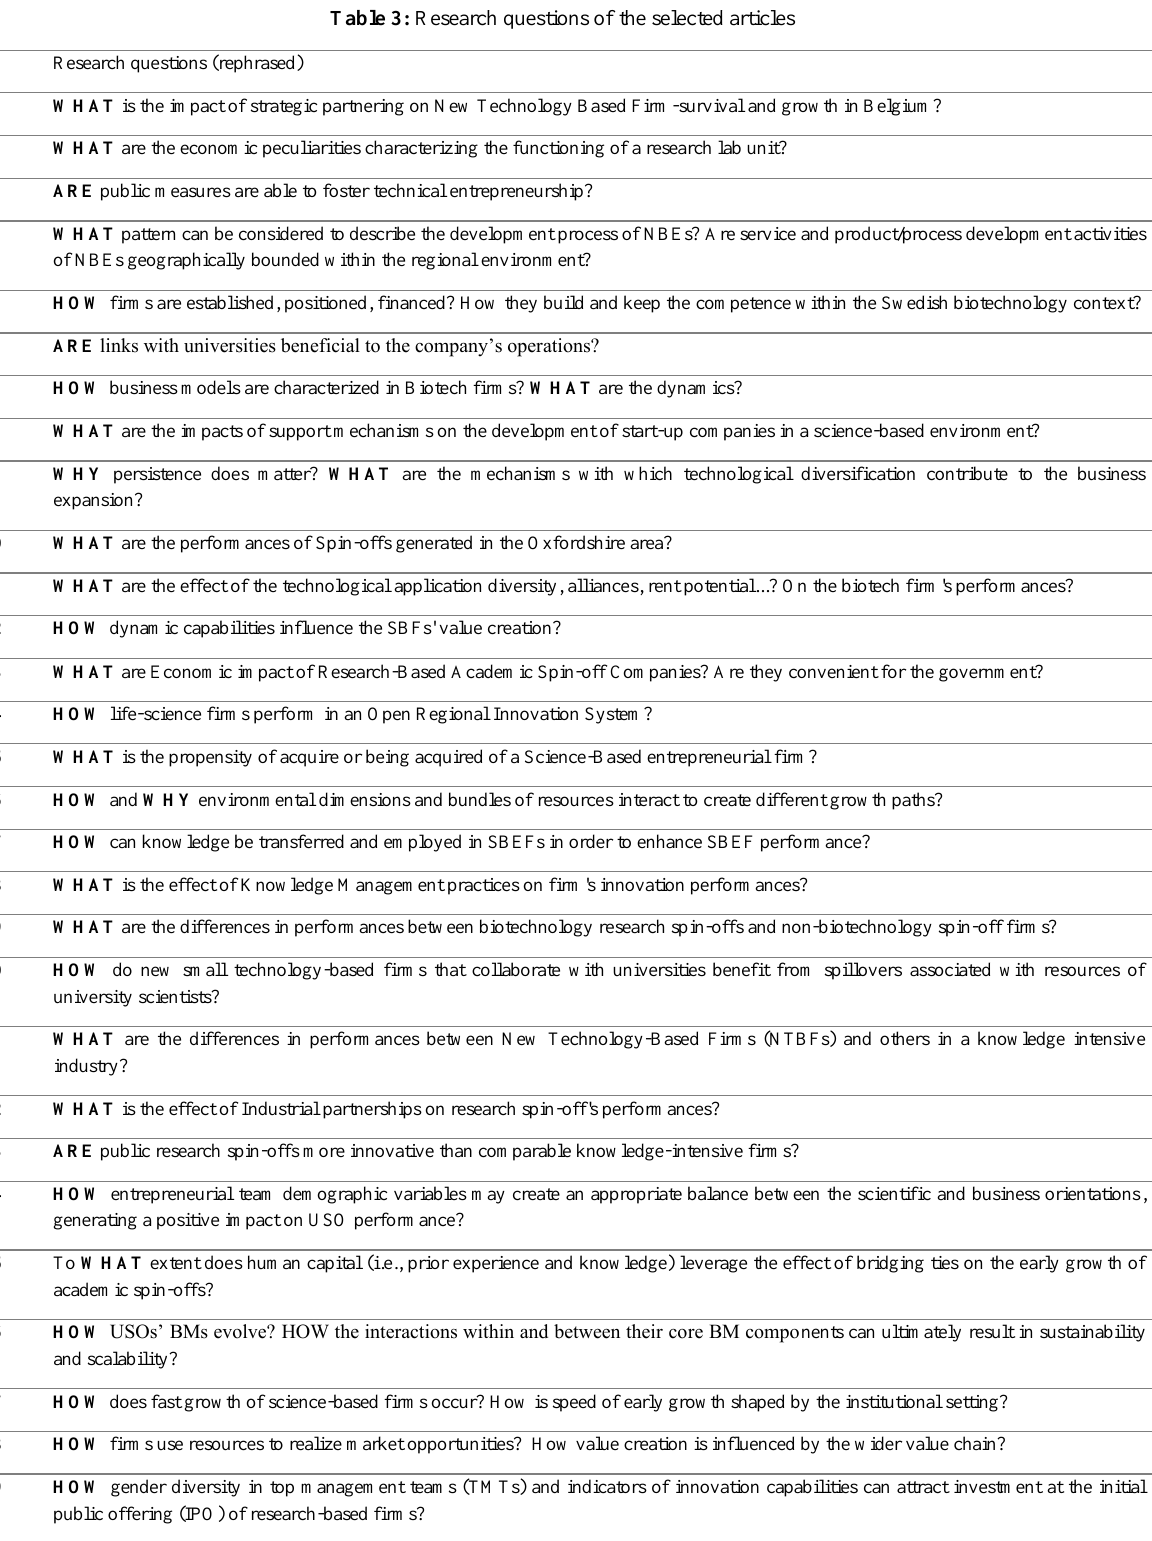
Table 3: Research questions of the selected